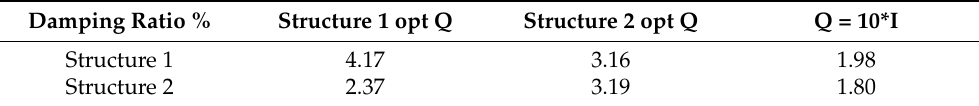
Table 4. Influence of different weighting parameters on structural damping ratio.